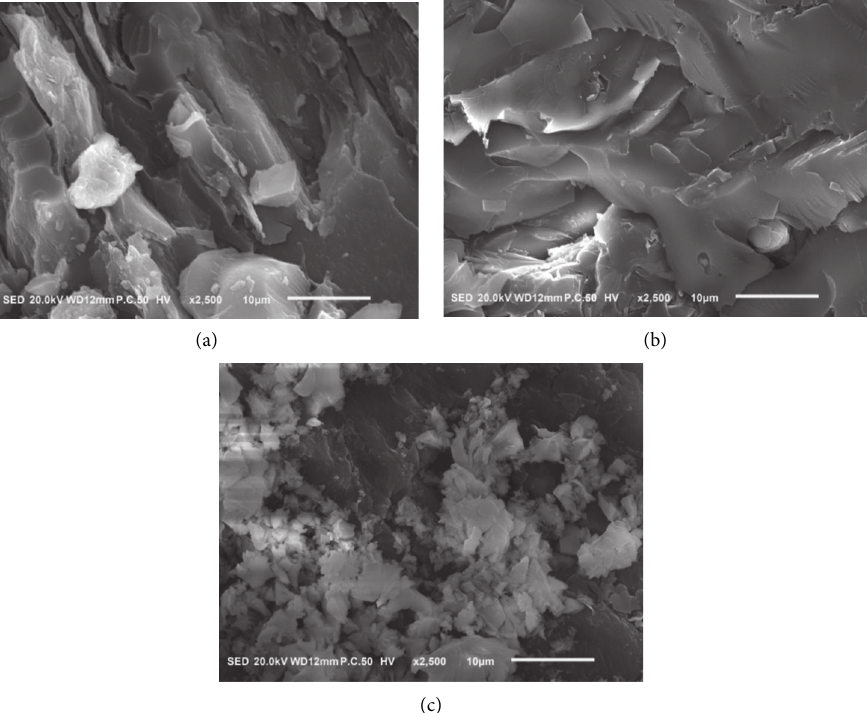
Figure 5: SEM micrographs of coal affected by static blasting: (a) 1 # raw coal; (b) 2 # coal after thermal action of the static blasting material; (c) 3 # coal adsorbed by the static blasting material.